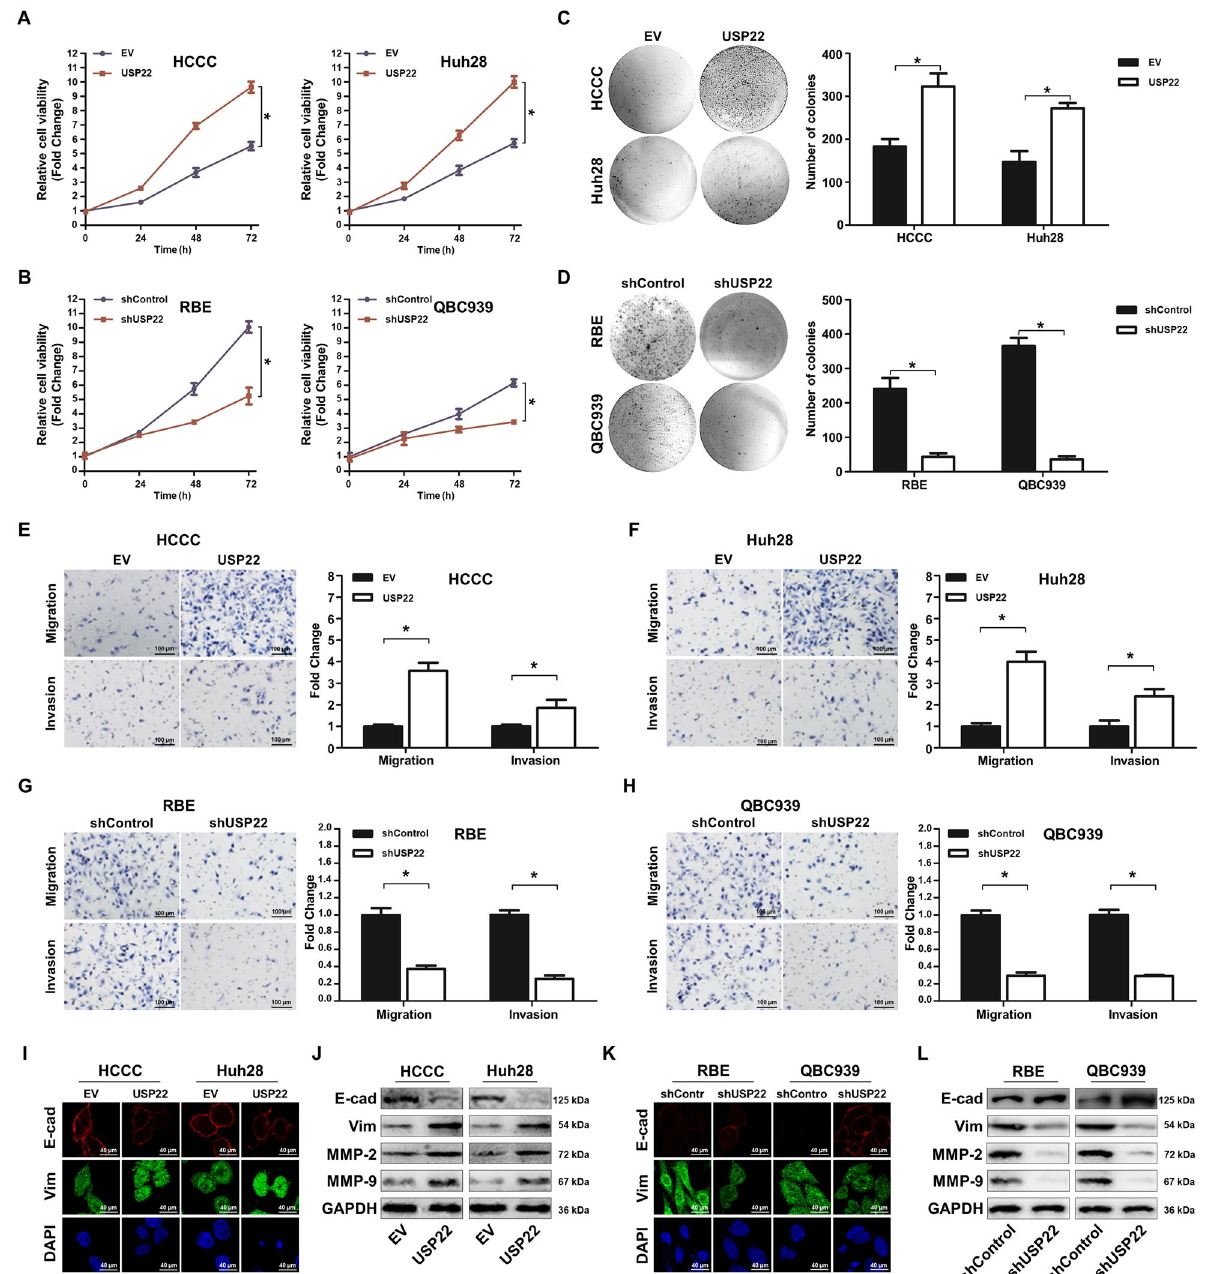
Fig. 2 USP22 promotes cell proliferation, migration and invasion, and induces CCA EMT in vitro. A – B HCCC-USP22, Huh28-USP22, RBE- shUSP22, QBC939-shUSP22 and their controls were cultured and their proliferation was evaluated once a day for 3 consecutive days by CCK8 assay. C – D Each cell line was seeded into six-well plates with 5,000 cells/well. Colonies formed after 14 days were fi xed and stained for quanti fi cation. E – H Cells were plated in cell inserts with 1 × 10 4 cells/insert (8 µm pore size) with/without matrigel for invasion or migration assay, respectively. After 24 h, fi ve images per insert were randomly taken and quanti fi ed by ImageJ. I – J HCCC-USP22, Huh28-USP22 and their controls were cultured for 48 h. The cells were fi xed and immunostained with antibodies to E-cadherin (red) and Vimentin (green), and with DAPI for DNA. Cell lysates from these cell lines were also prepared for immunoblotting analysis with antibodies to E-cadherin, Vimentin, MMP2, MMP9 and GAPDH. K – L RBE-shUSP22, QBC939-shUSP22 and their controls were cultured for 48 h. The cells were fi xed and immunostained with antibodies to E-cadherin (red) and Vimentin (green), and with DAPI for DNA. All data are presented as the mean ± SD (* p < 0.05, n =